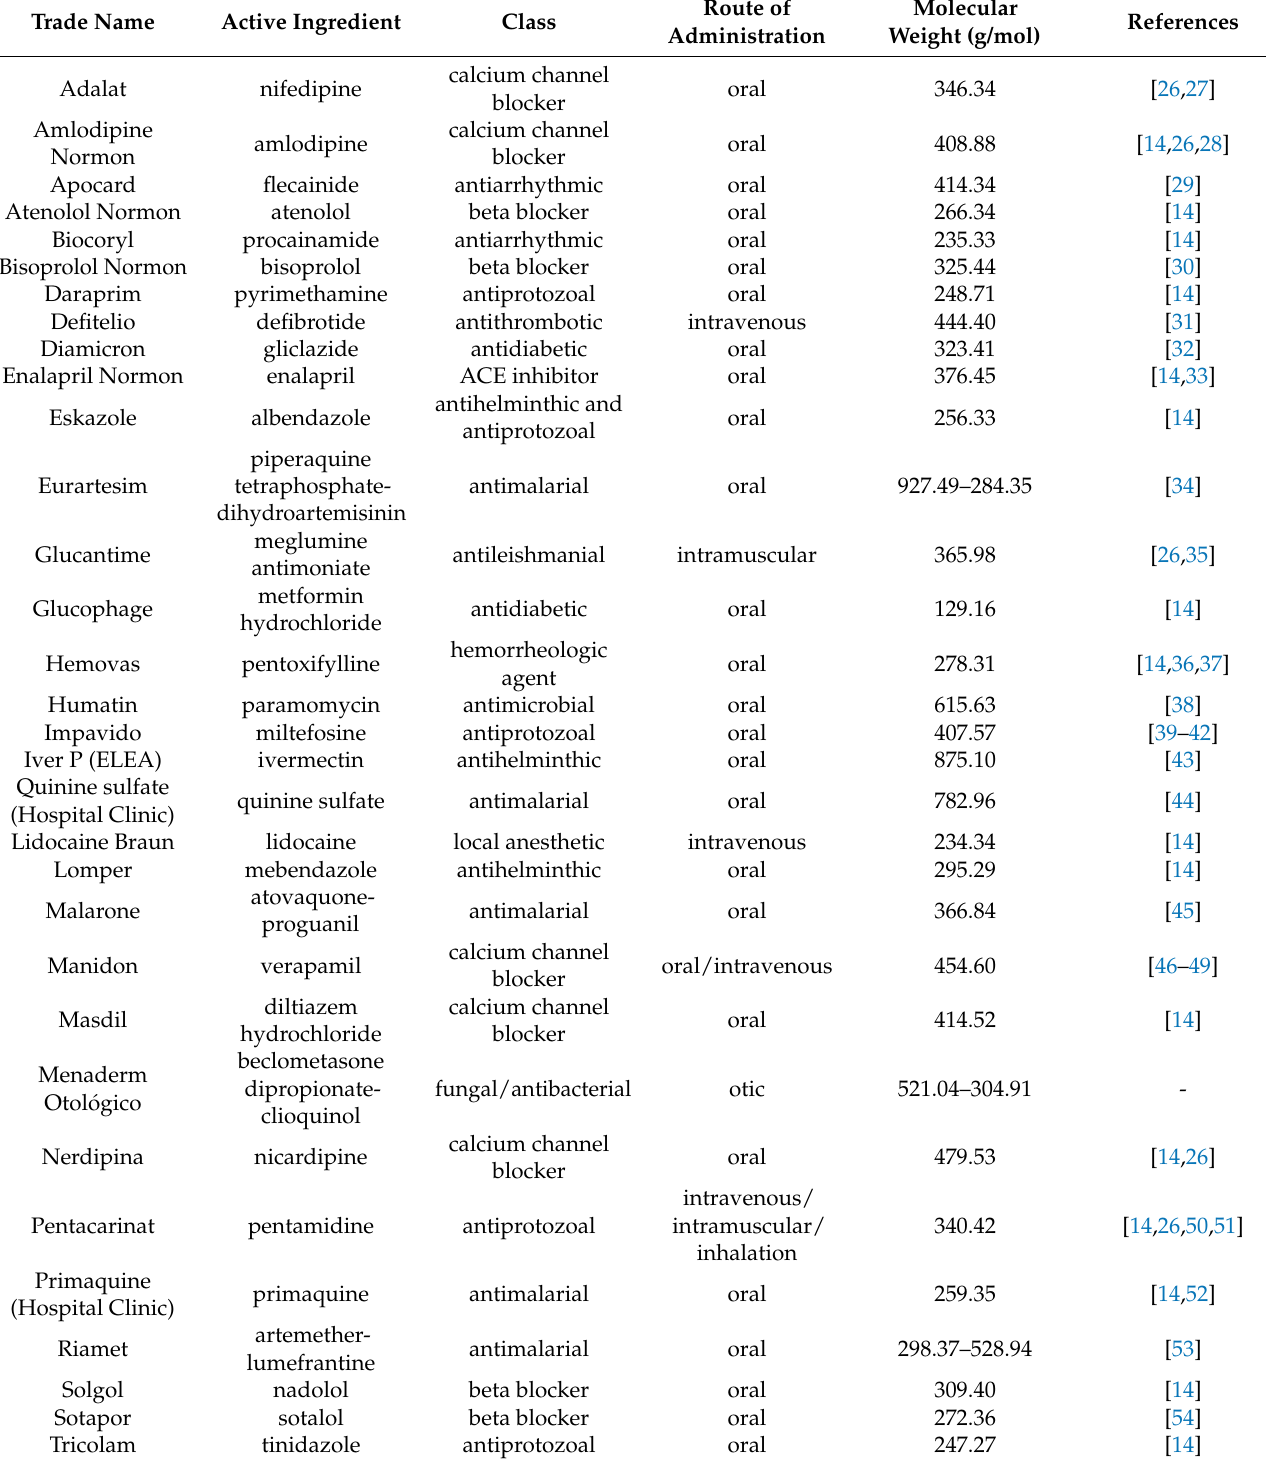
Table 1. Drugs used in the study. They are sorted by their “Trade name” in alphabetical order. (Table 1 continues in next